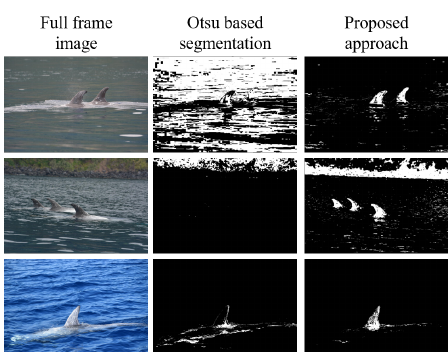
Figure 9. Qualitative comparison of the proposed segmentation approach with the Otsu based